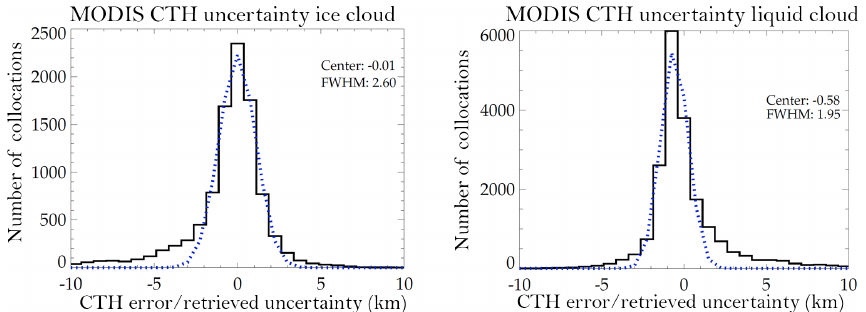
Figure 5. Example of uncertainty validation using the distribution of differences between matched cloud top heights measured by Cloud CCI (data) and CALIPSO (CALIPSO values minus those from MODIS AQUA Cloud CCI) for a single day, 20 June 2008 (solid black); (left) for ice clouds, (right) for liquid clouds. The plots show the histograms of the CTH error (the difference in retrieval compared to validation data that is assumed to have negligible uncertainty) divided by the stated retrieval uncertainty. For ideal uncertainty estimates the full width at half maximum (FWHM) of the fitted Gaussian distribution (dashed blue) would be